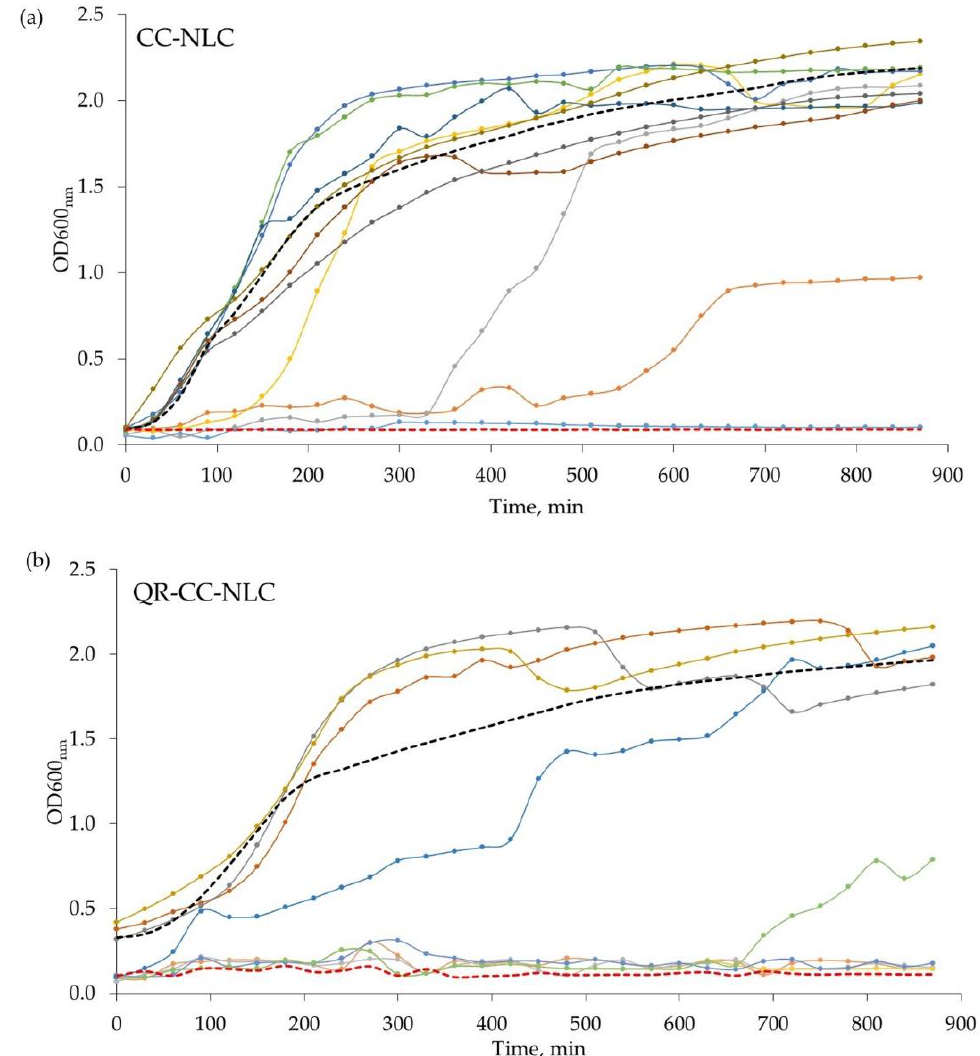
Figure 12. S. aureus growth in the presence of ( a ) CC-NLC and ( b ) QR-CC-NLC; S. aureus : 5 × 10 3 cells/well, incubation at 37 °C, with constant shaking for 16 h, OD600 nm was measured every 30 min. NLC concentration per well: Well 1 — 2.25 mg·mL − 1 ; Well 2 — 1.125 mgmL −1 ; Well 3 — 0.563 mg·mL −1 ; Well 4 — 0.281 mg·mL −1 ; Well 5 — 0.141 mg·mL −1 ; Well 6 — 0.070 mg·mL −1 ; Well 7 — 0.035 mg·mL −1 ; Well 8 — 0.018 mg·mL −1 ; Well 9 — 0.009 mg·mL −1 ; Well 10 — 0.004 mg·mL −1 ; Well 11 — only S. aureus ; Well 12 — sterility control. Each experiment was repeated in triplicate.